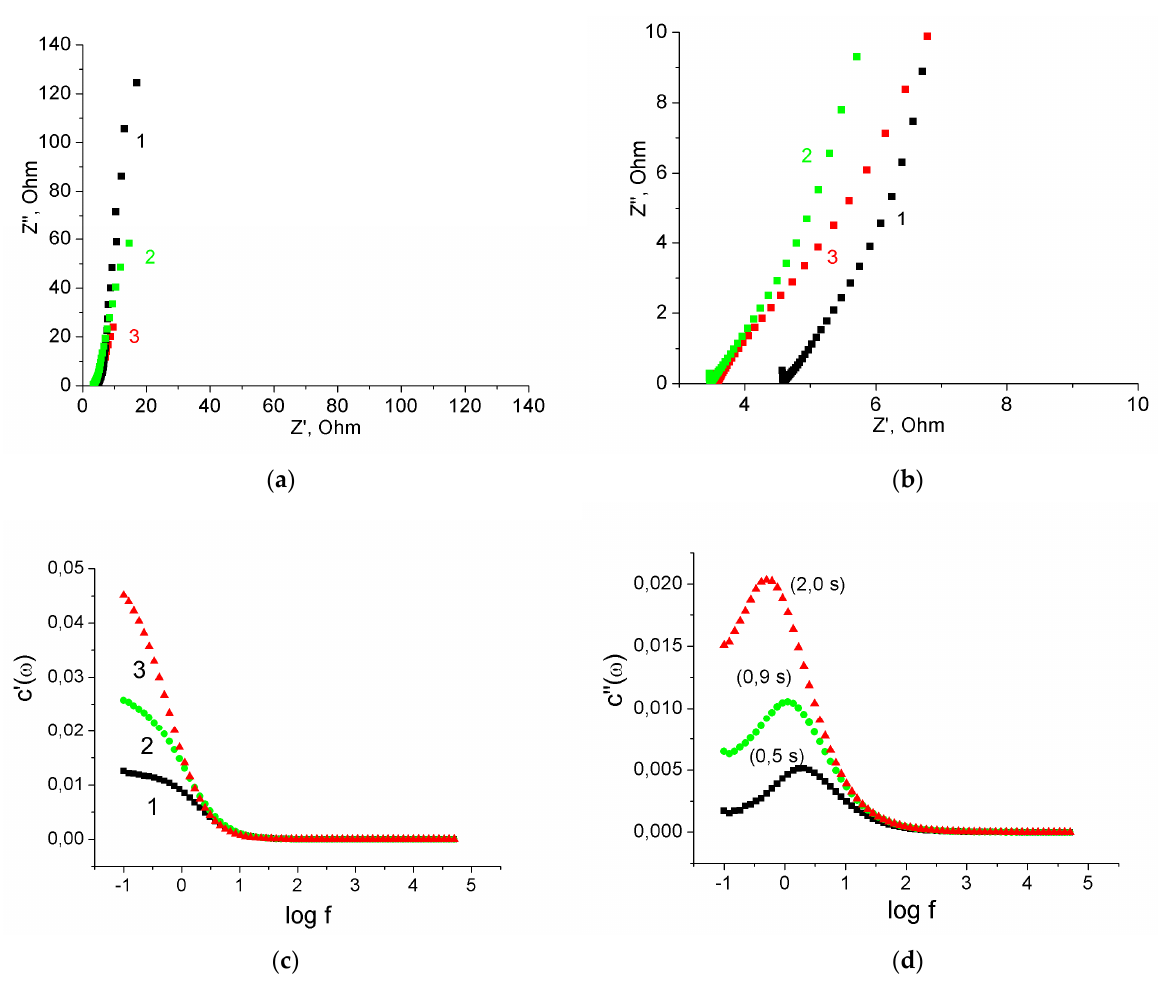
Figure 9. ( a ) The Nyquist plots of the three-electrode cell (full range); ( b ) The Nyquist plots of the three-electrode cell (middle range); ( c ) Frequency dependences of the real capacitances; ( d ) Fre- quency dependences of the imaginary capacitances. As-prepared MWCNT/Al sample 1, oxidized MWCNT/Al sample 2, MnO 2 /MWCNT/Al sample 3.